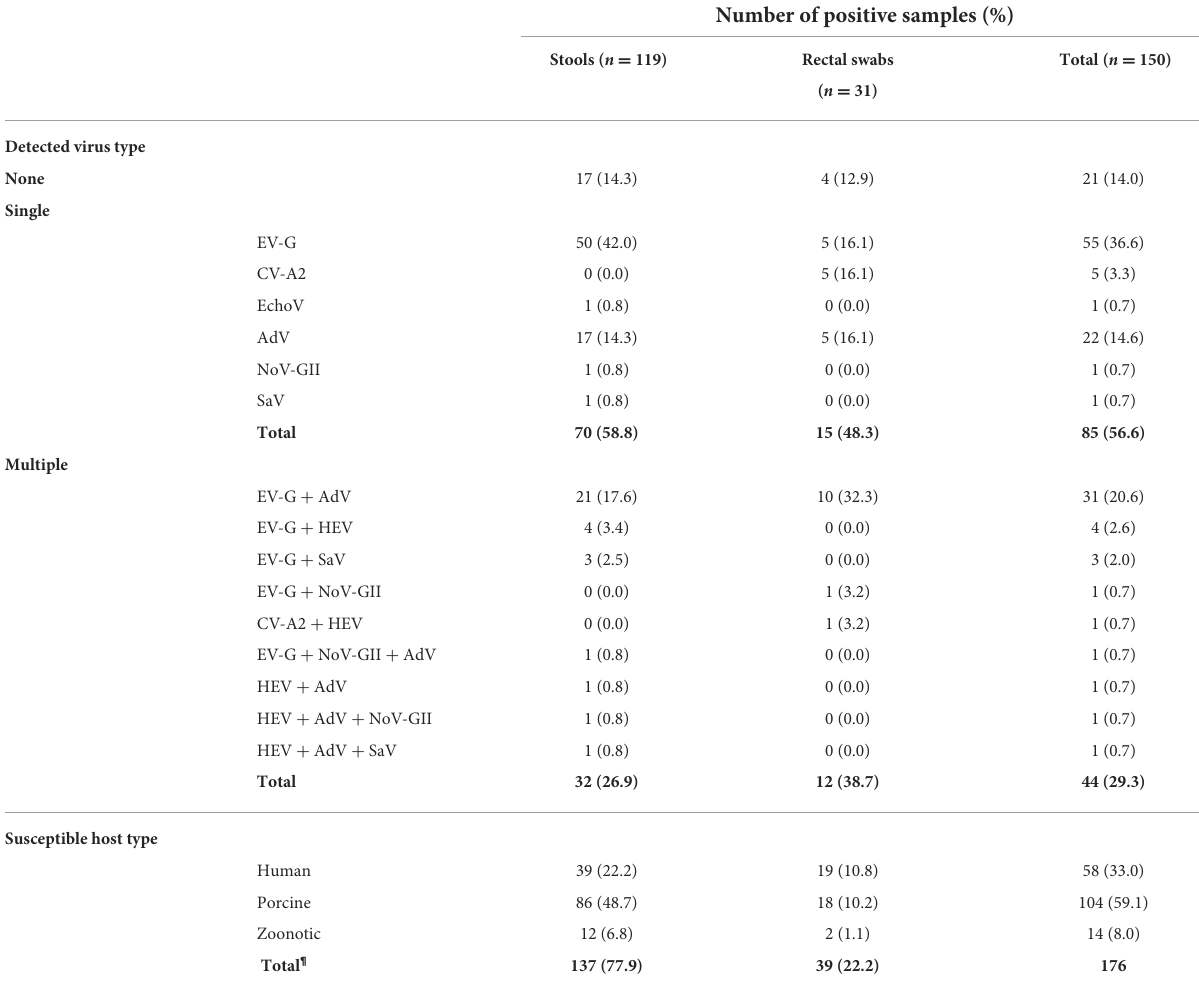
Number of positive samples